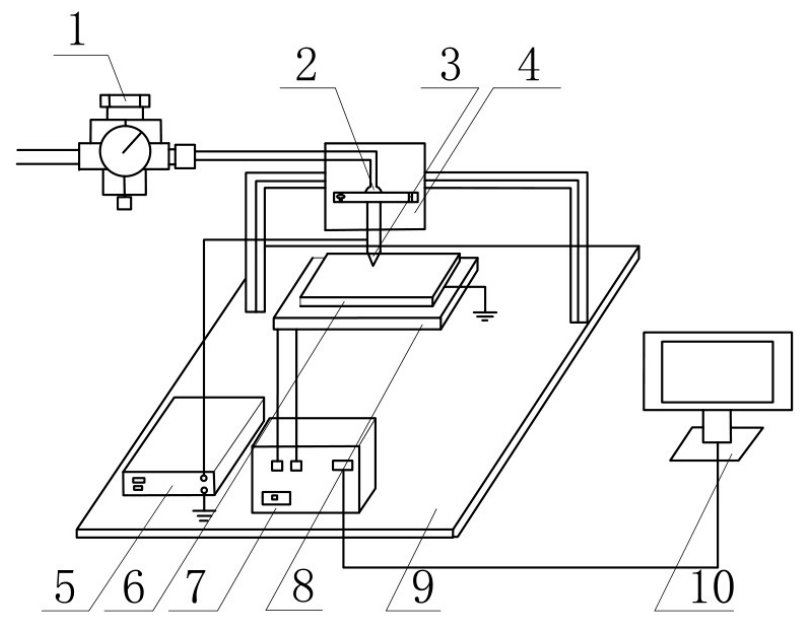
Figure 1. Schematic diagram of the printing system.